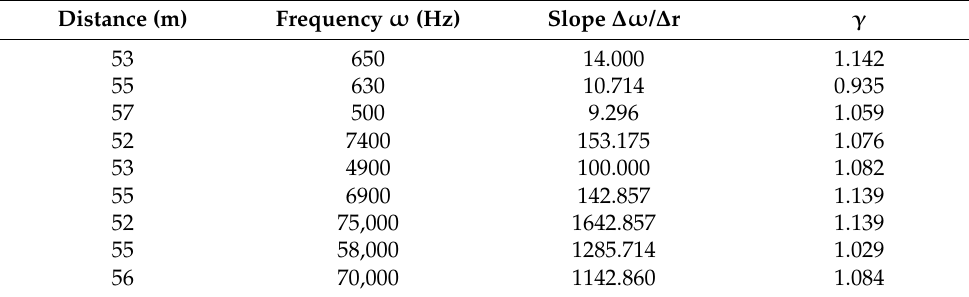
Table 2. The slopes and invariants for the bistatic